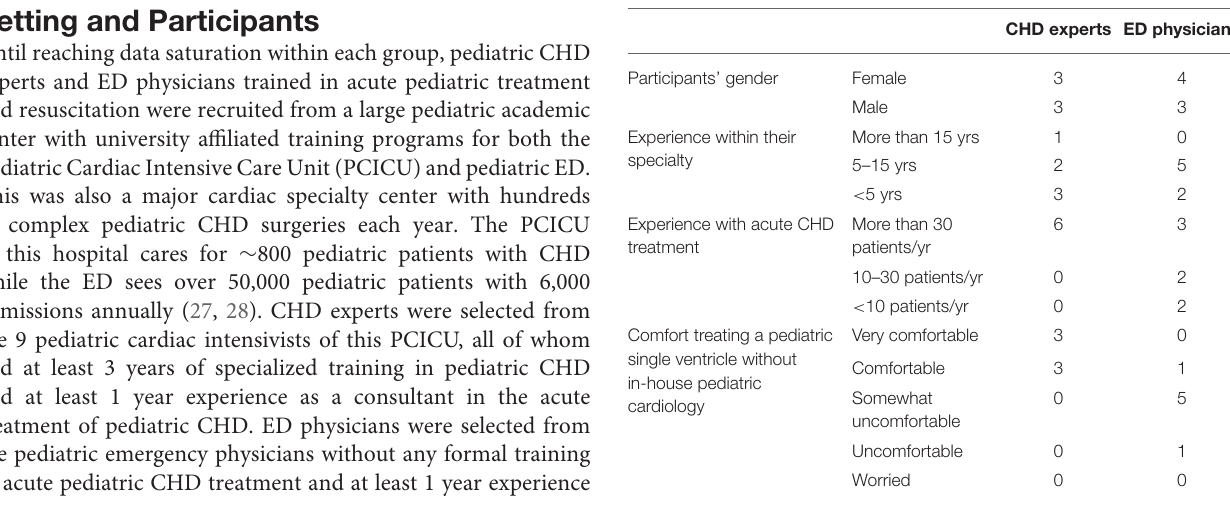
TABLE 1 | Participant